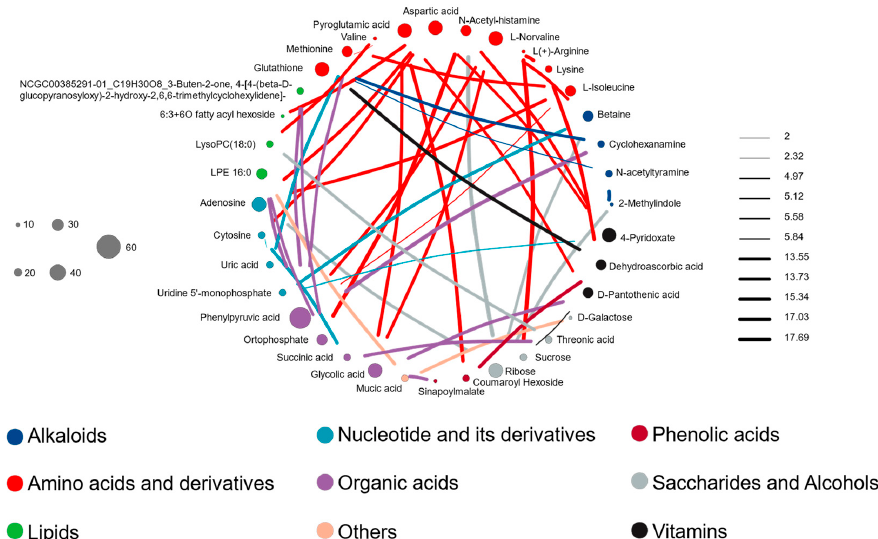
Figure 6. Differential metabolite correlation network. The size of each node represents the connec